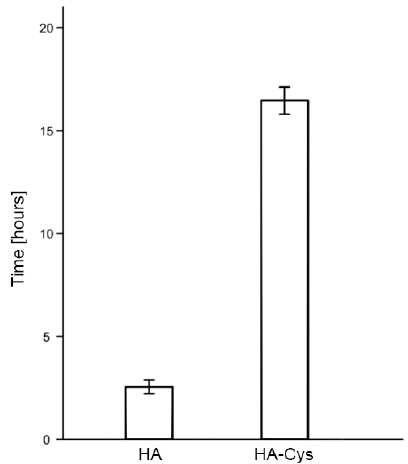
Figure 2. Adhesion time in hours of unmodified HA and HA-Cys on the rotating cylinder in 0.1 M phosphate buffer pH 6.8 with 1% NaCl at 37 °C. Indicated values are means of at least three experiments (±SD). Adapted from Kafedjiiski et al. [14].